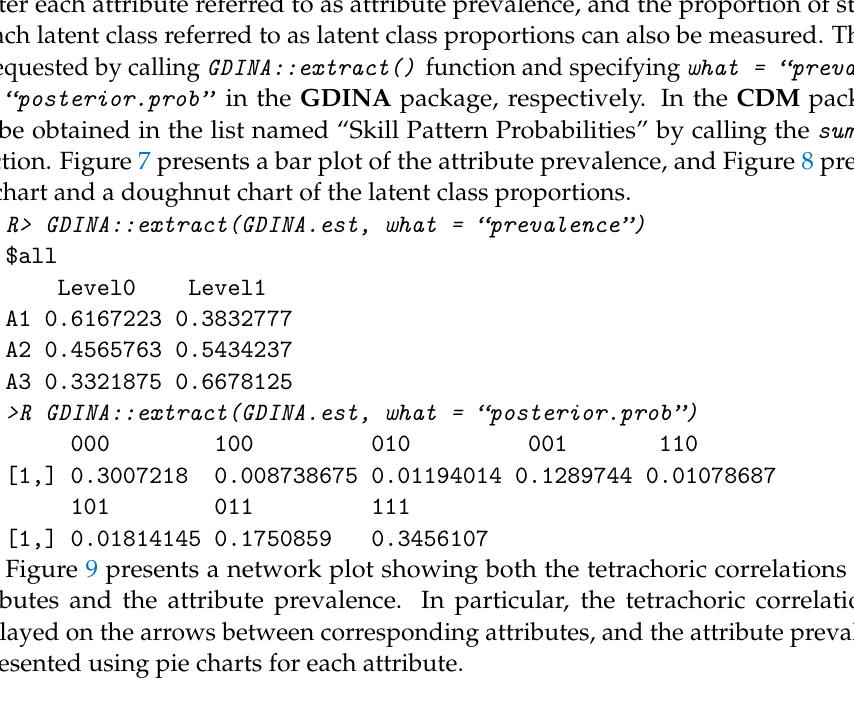
Figure 7. The bar plot of attribute prevalence. >R GDINA::extract(GDINA.est, what = “posterior.prob”) 000